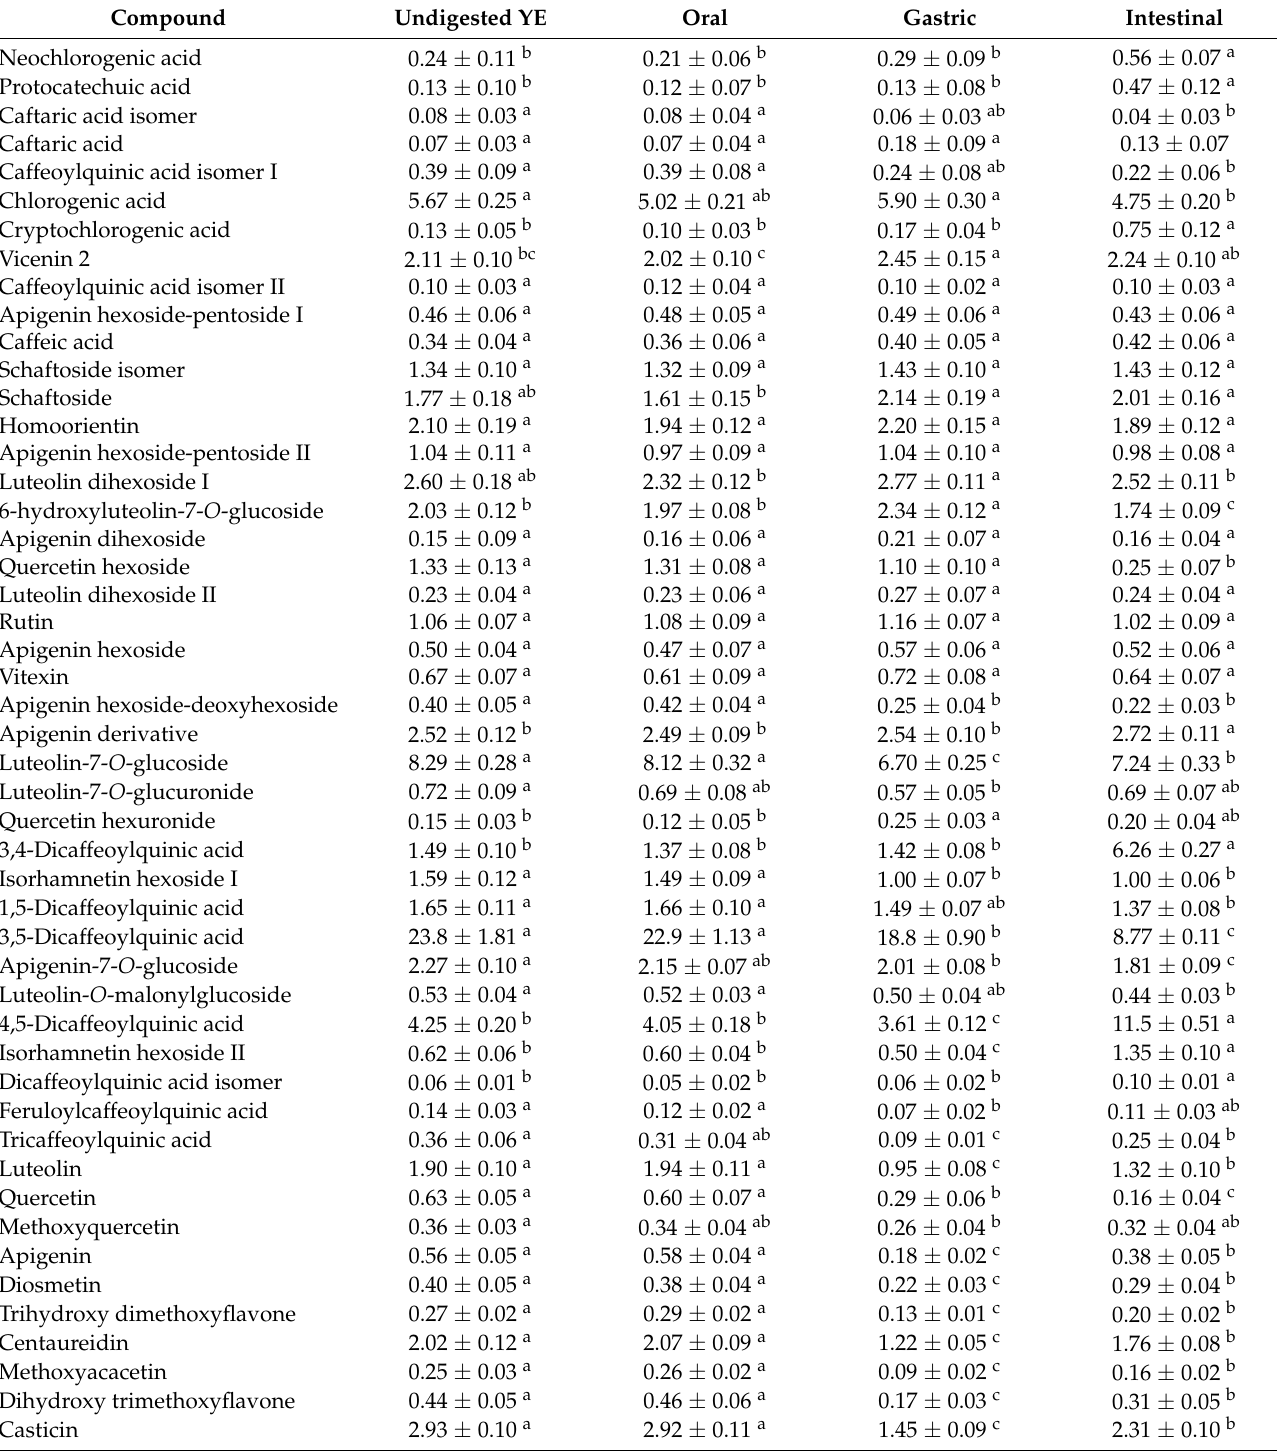
Table 1. Phenolic composition (mg/g extract) of yarrow extract (YE) before and after oral, gastric and intestinal digestion